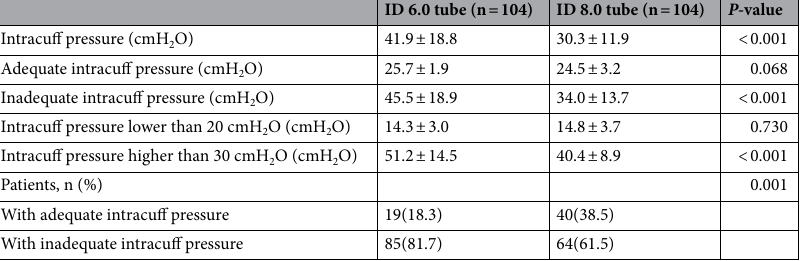
Table 2. Adequacy of intracuff pressure between ID 6.0 and ID 8.0 endotracheal tube. Values are presented as mean ± SD or number (proportion). ID internal diameter.